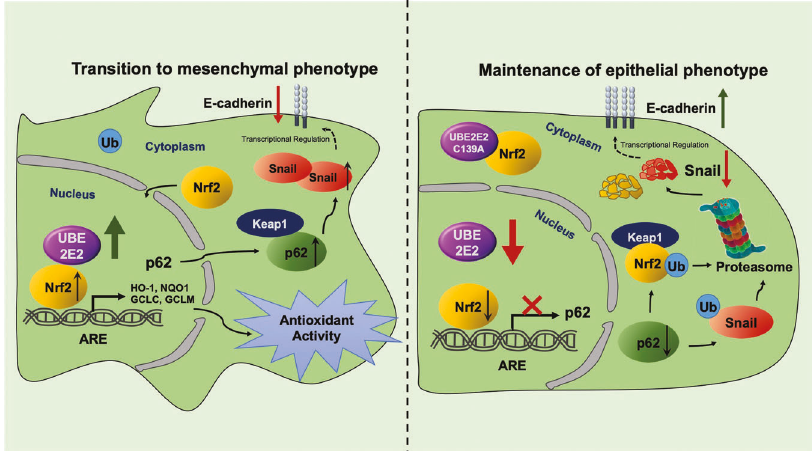
Fig. 8 Model illustrating the role played by UBE2E2 in OvCa cell progression. UBE2E2 enhances epithelial-mesenchymal transition and antioxidant capacity of OvCa cells via modulation of Nrf2/p62 and Snail